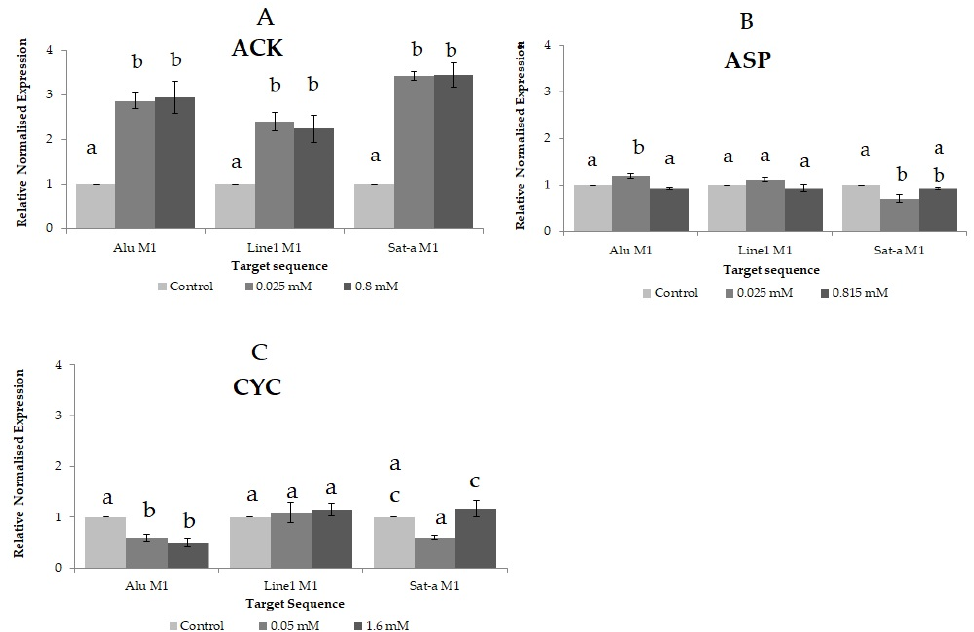
Figure 5. Relative normalised expression data of each repetitive element when HL-60 cell line was treated with ACK ( A ), ASP ( B ) and CYC ( C ). Different letters are associated with different means applying the One-Way ANOVA test and post hoc Tuckey’s test.